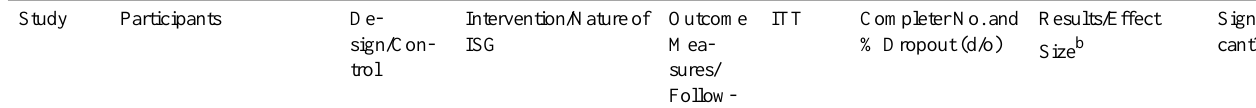
Table 1. Study characteristics and findings for single-component or cross-sectional studies a